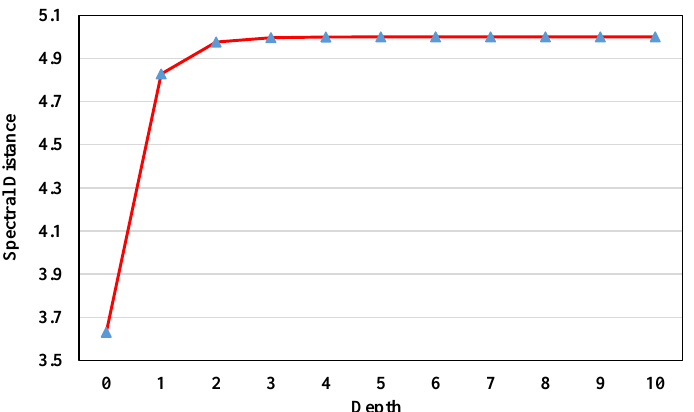
Figure 4. The spectral distances between sensor-observed spectrum r ( λ ) and land-based spectrum r B ( λ ) with different depth